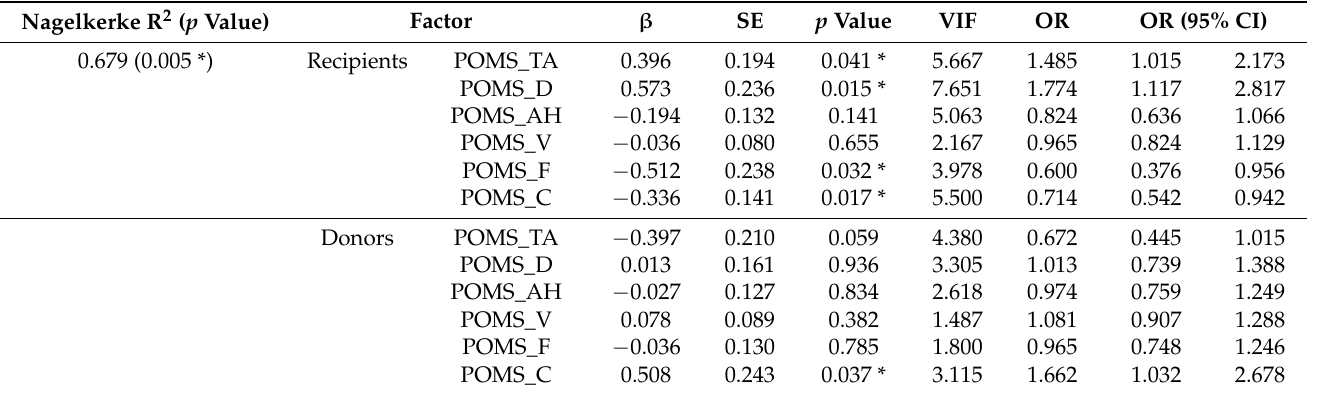
Table 4. Significant impact factors of POMS on choosing between PEKT and PDKT. * p < 0.05 according to binomial logistic regulation analysis with robust standard errors. Multicollinearity was suspected if the VIF value was greater than 10. * p < 0.05: significant impact factor on choosing between PEKT and PDKT for recipients and donors.